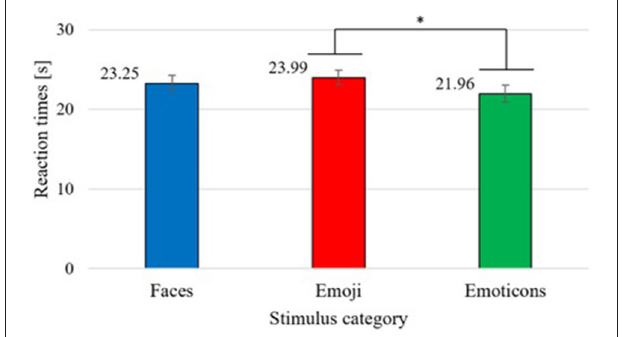
FIGURE 6 | Mean reaction times in seconds for each stimulus category. Error bars depicted in standard errors ( SE ). * p < 0.05.